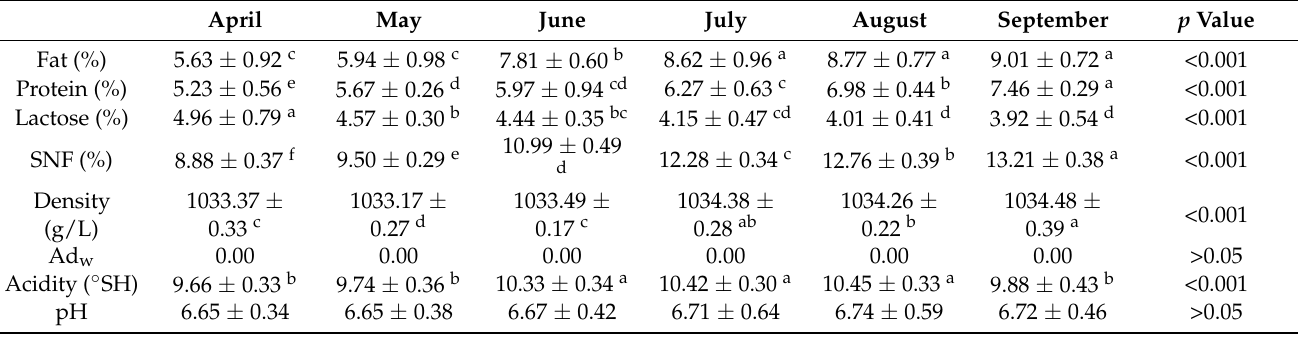
Table 1. Means and their standard deviations (SD) of the physical and chemical indicators of sheep’s milk depending on the month of milking.